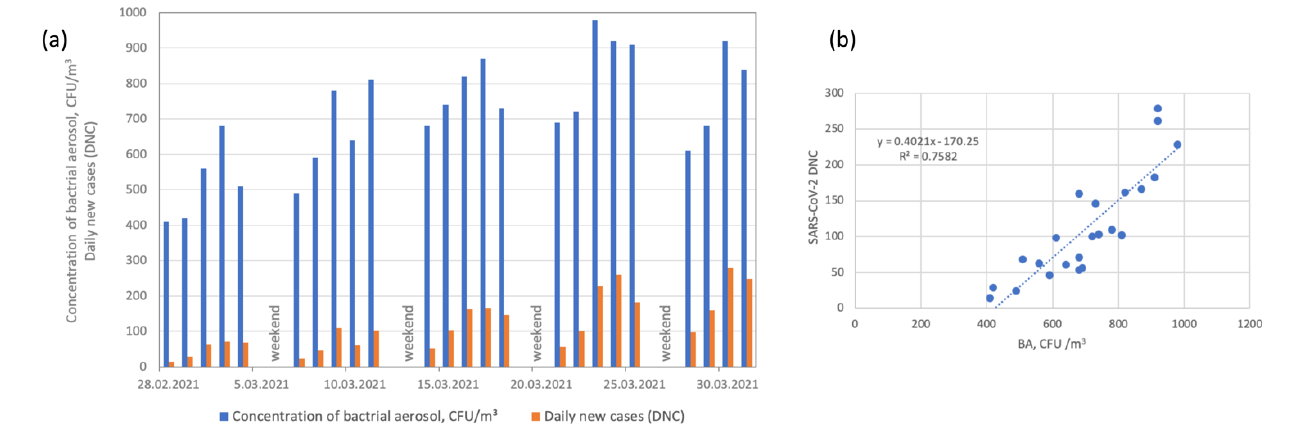
Figure 6. ( a ) Bacterial aerosol (BA) concentrations and SARS-CoV-2 daily new cases (DNCs). ( b ) Linear regression coefficients between bacterial aerosol (BA) concentrations and SARS-CoV-2 daily new cases (DNCs).